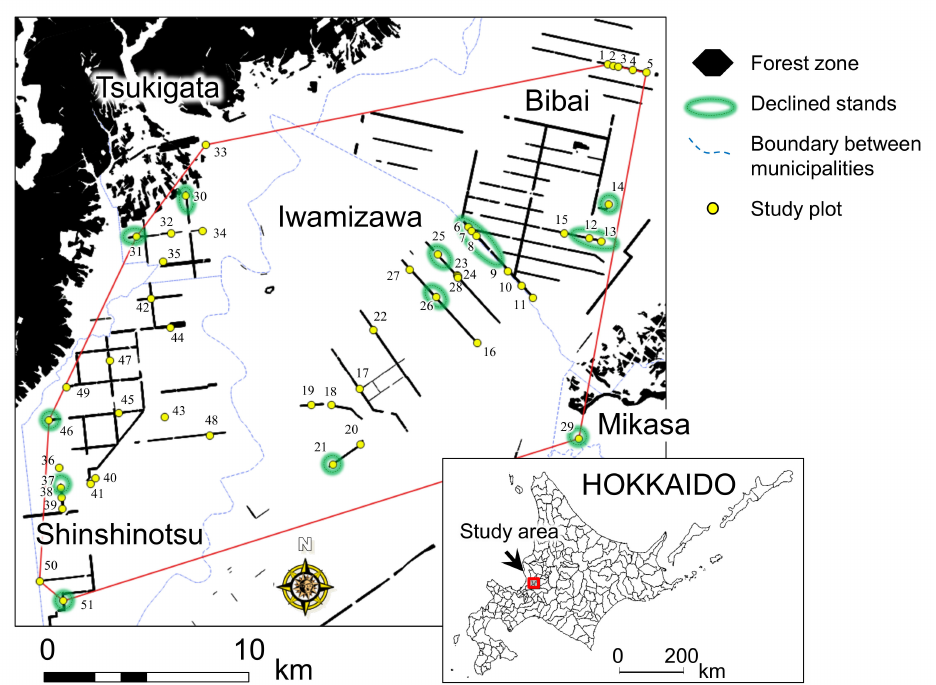
Figure 2. Study area, indicated by the